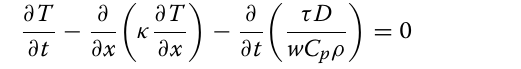
If we assume that the stress normal to the fault is equal to hydrostatic stress (i.e., horizontal stress is equal to vertical stress), the amount of frictional heat produced during slip is directly related to the product of the fric- tion coefficient, vertical stress, and slip distance. Dur- ing earthquake slip, the friction coefficient of the clayey plate-subduction slip zones is commonly 0.1 (e.g., Ujiie and Tsutsumi 2010; Di Toro et al. 2011), so we adopted this value. The burial depths (equivalent to depth to the subducting plate) of the faulted strata of the Emi Group and Kure Mélange have previously been determined to be 1–4 and 2.5–5.5 km, respectively (Mukoyoshi et al. 2006; Hirono et al. 2008b), so we adopted representative depths of 2 and 4 km for the Emi Group and 3 and 5 km for the Kure Mélange. Slip rates during past earthquakes are unknown, so we tested three values (0.1, 0.5, and